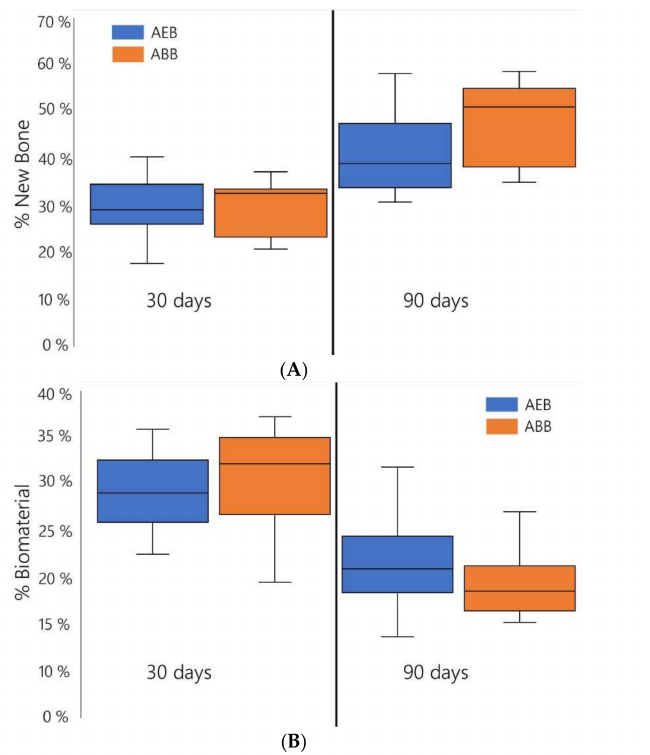
Figure 7. Box plot representation of the percentage of newly formed bone (( A ) top panel) and of residual biomaterial (( B ) bottom panel) in samples that were grafted with AEB or with ABB. No statistical differences are present between the two